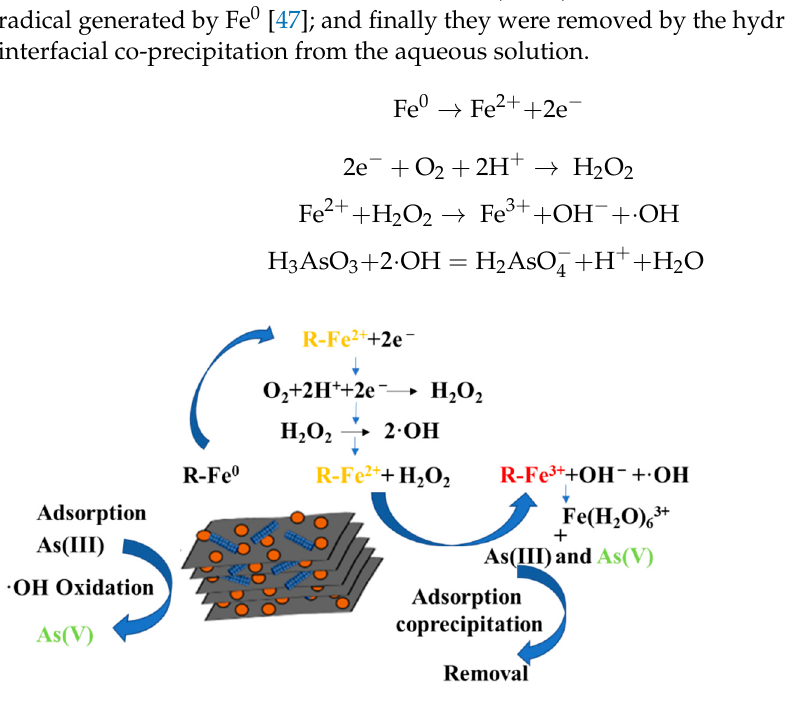
Table S3: The fitting parameters of Langmuir and Freundlich isotherm models for As(III) adsorp- tion by nZVI/MXene@CNTs; Table S4 The fitting parameters of thermodynamic model for As(III) adsorption by nZVI/MXene@CNTs. References [67,68] are cited in the supplementary